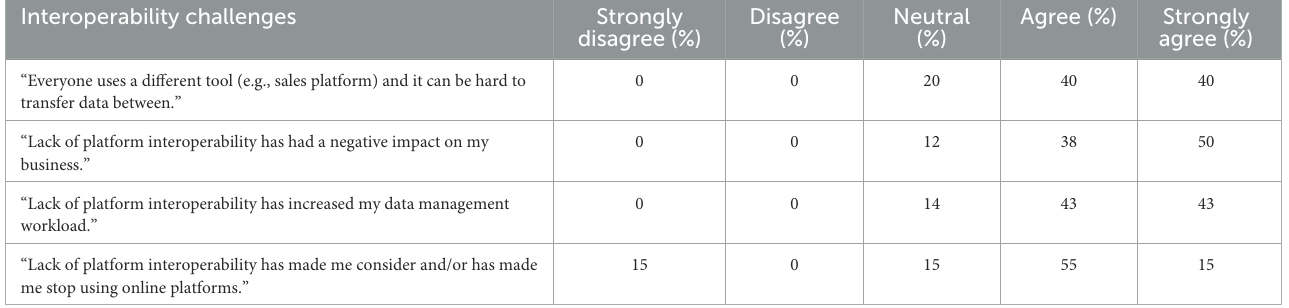
TABLE 3 Summary of responses related to lack of inter-platform interoperability. Interoperability challenges